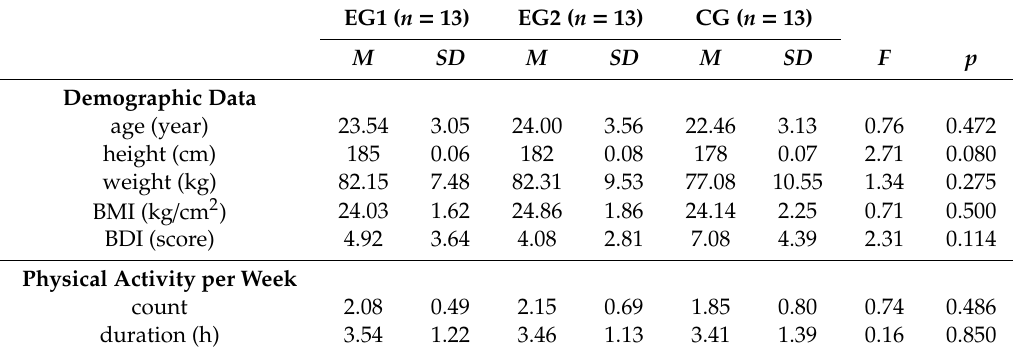
Table 1. Demographic